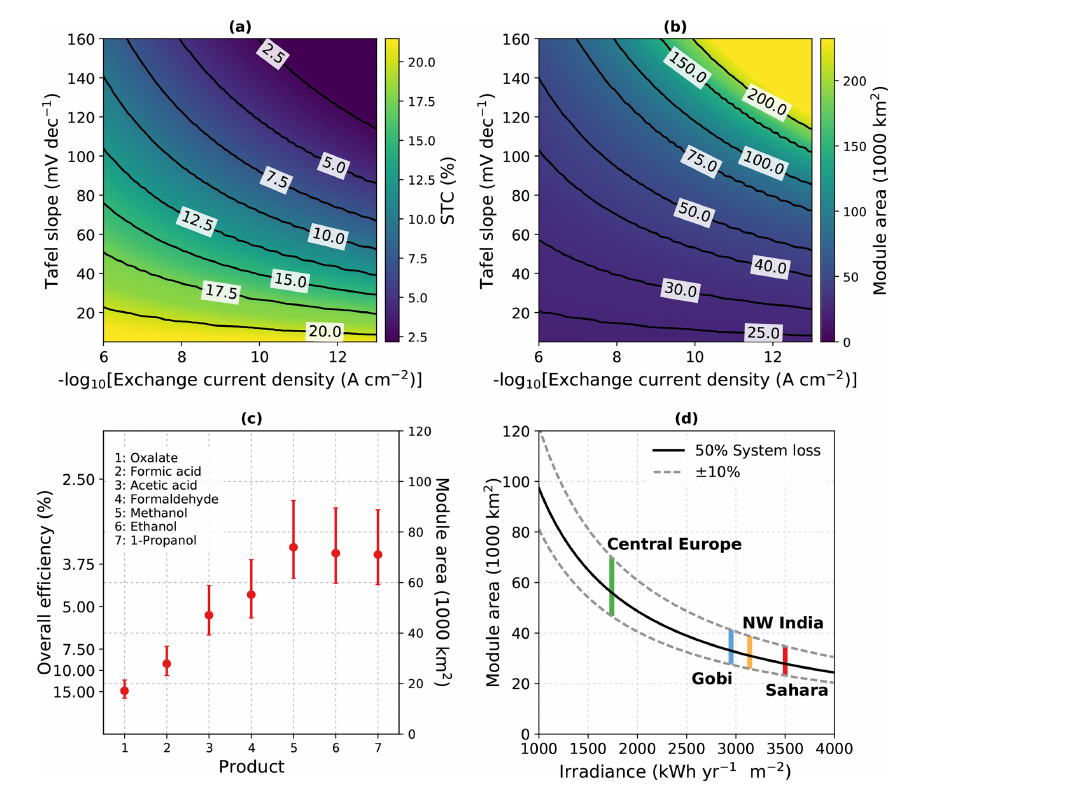
Figure 1. Theoretical efficiency limits and module area for the − 10GtCO 2 yr − 1 scenario. (a) STC efficiency limit of a dual-junction absorber for formic acid (without system loss) as a function of exchange current density and Tafel slope. (b) Resulting module area at Sahara irradiance and 50% system loss. (c) STC efficiency and module area required under Sahara irradiance for a selection of products at 50% system loss. Error bars indicate 40% and 60% loss, respectively. (d) Module area for formic acid production over the yearly irradiance at 50% (solid line), as well as 40% and 60% (dashed lines) system loss. Vertical lines mark typical irradiances accessible to a two-axis